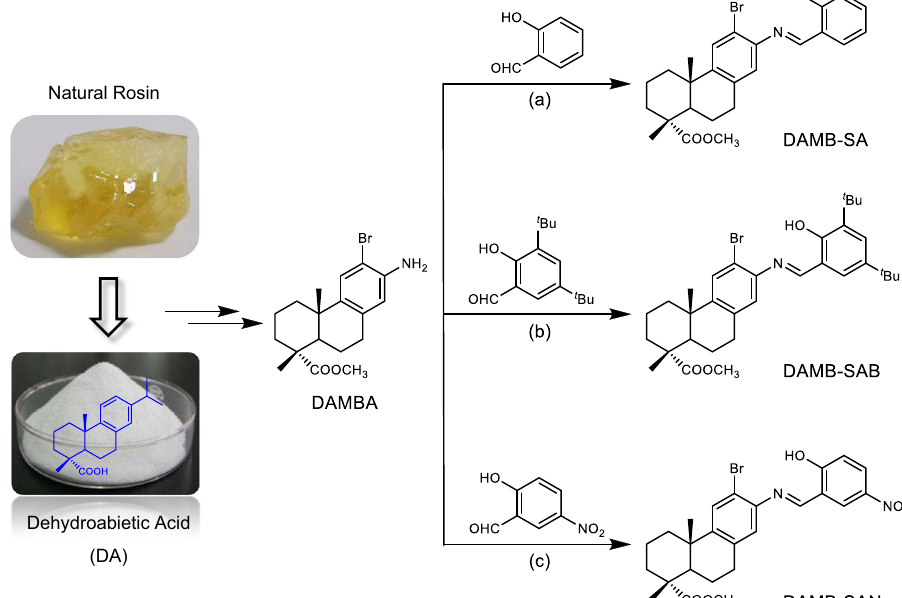
Fig. 1 Schematic illustration of molecular synthesis. Synthesis of dehydroabietic acid-derived Schiff bases: a EtOH, 90 °C, 10 h; b EtOH, 100 °C, over night; c EtOH, 85 °C, 3 h.